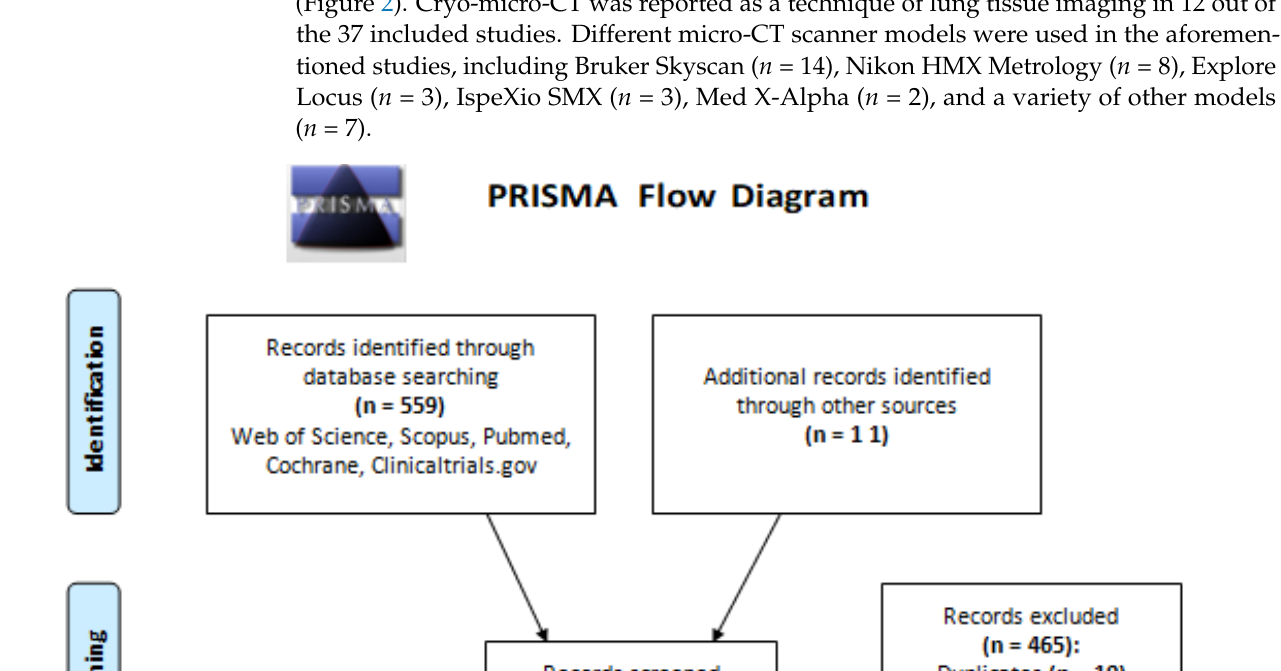
Locus ( n = 3), IspeXio SMX ( n = 3), Med X-Alpha ( n = 2), and a variety of other models ( n = 7).